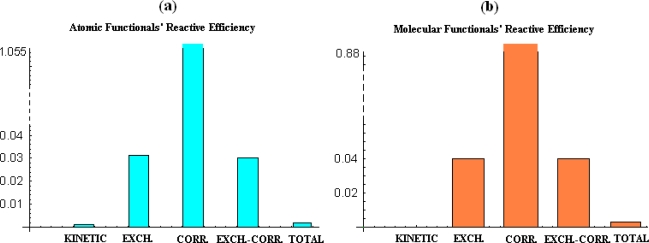
Charts of energetic functionals showing their reactive efficiency (196) as the height of bars for the parabolic expansion and of their statistical correlation (192) as the width of bars, in terms of electronegativity and chemical hardness, resuming atomic analysis of Tables I–III - in (a), and molecular one from Tables IV and V - in (b), by employing representative values of Tables VI and VII (highlighted on grey background), respectively.